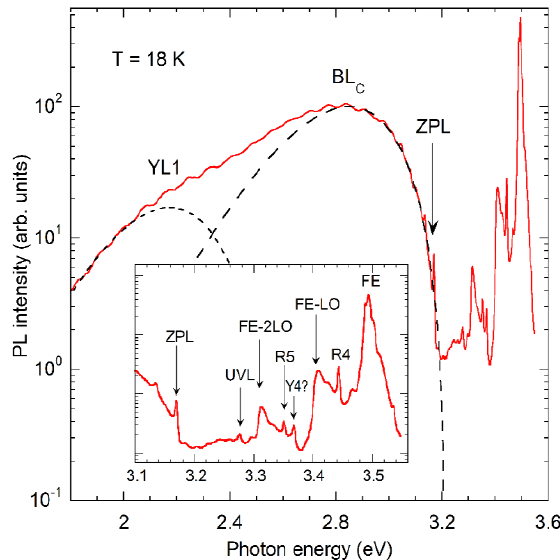
Figure 2. PL spectrum at 18 K and P exc = 100 W/cm 2 from GaN:C annealed at T ann = 800 °C. The dashed lines are calculated using Equation (1) with the same parameters as in Figure 1. The inset zooms in the high-energy part of the spectrum.